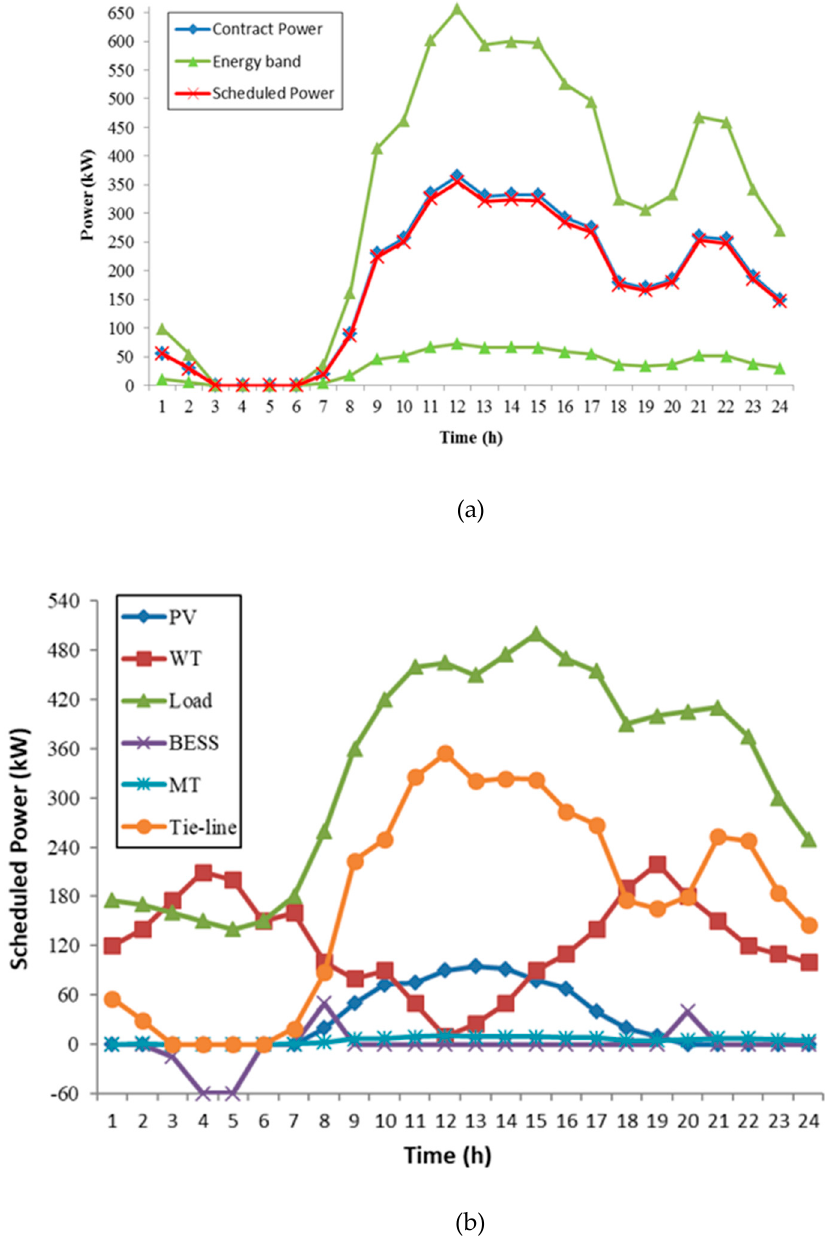
Figure 9. Scheduled power scheme for Case 2 for energy band of 80%: (a) Results for energy band, (b) Scheduled power volumes for distributed units.